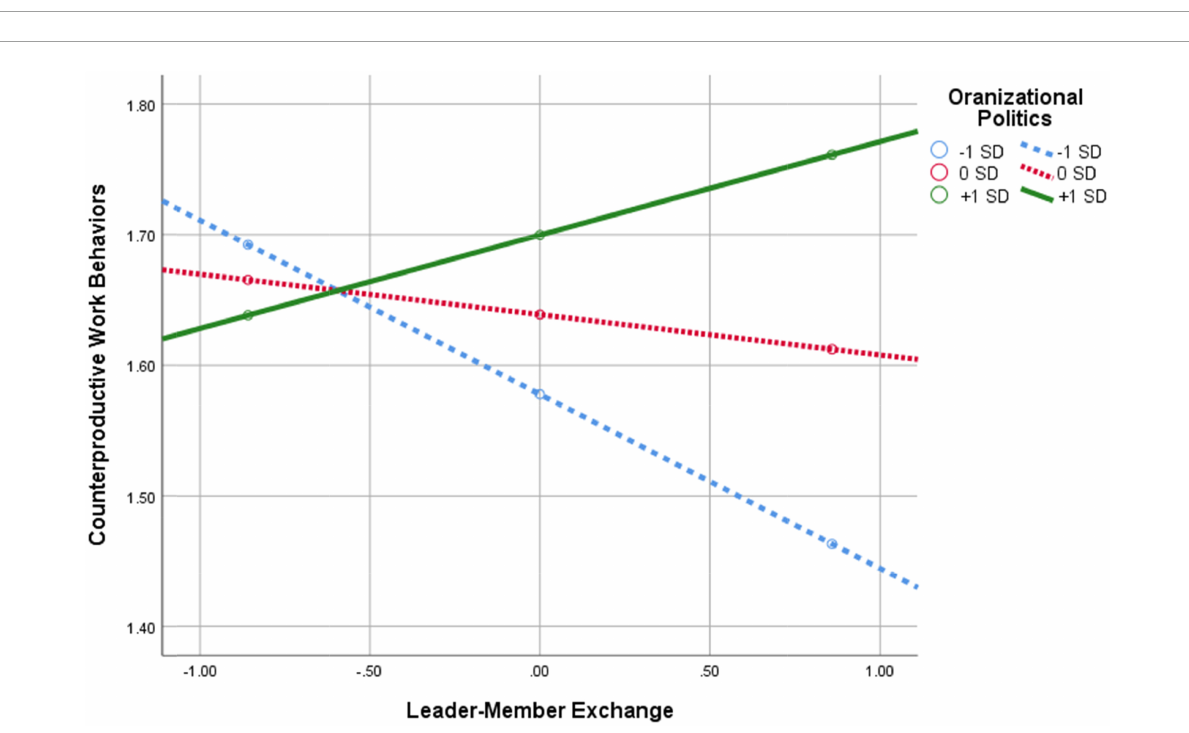
FIGURE4 Interaction of leader–member exchange × perception of organizational politics in predicting CWB.